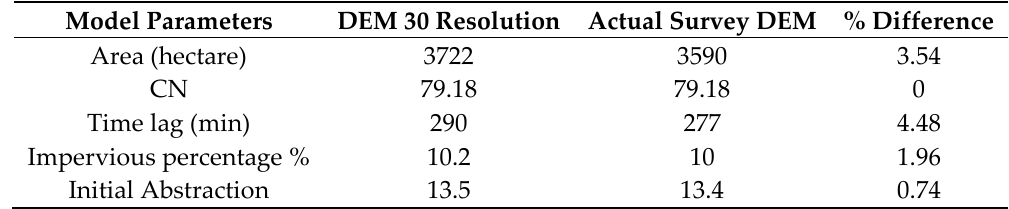
Table 3. Parameters of model obtained by using two sources (30 m and actual survey DEM) for Al Naqaa.